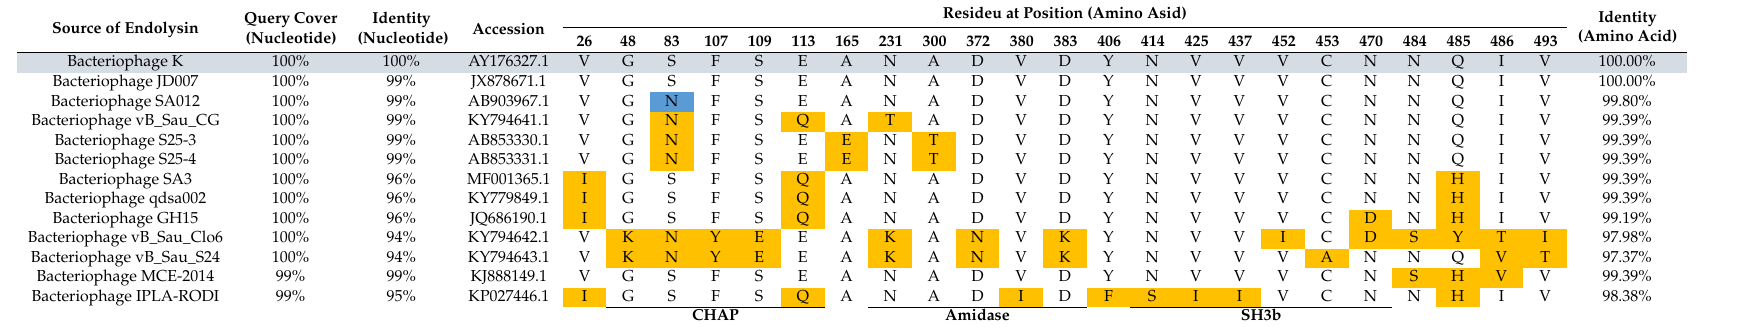
Table 4. LysK-like